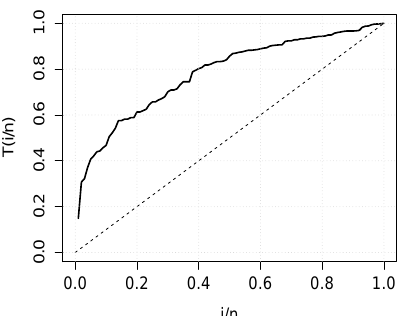
Figure 3 - The TTT-plot for the breaking stress of carbon fibres (in Gba)